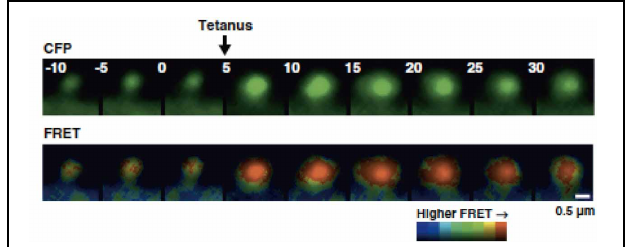
FIGURE 3 | Dendritic spine expressing actin FRET probe. Single dendritic spine that was subjected to local tetanic stimulation is accompanied by the enlargement of spine and actin polymerization. From Okamoto et al.